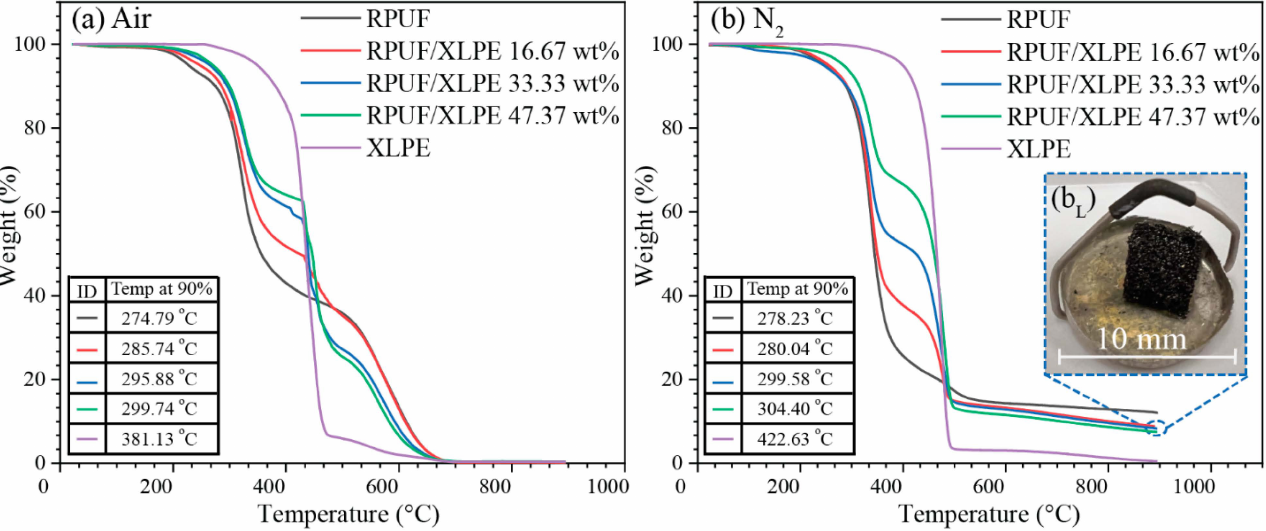
Figure 7. Thermogravimetric (TGA) tests of RPUF with XLPE additions and pure XLPE with the temperature at 10% weight loss in an atmosphere of ( a ) air, ( b ) N 2 , and ( b L ) the residue of RPUF/XLPE 47.37